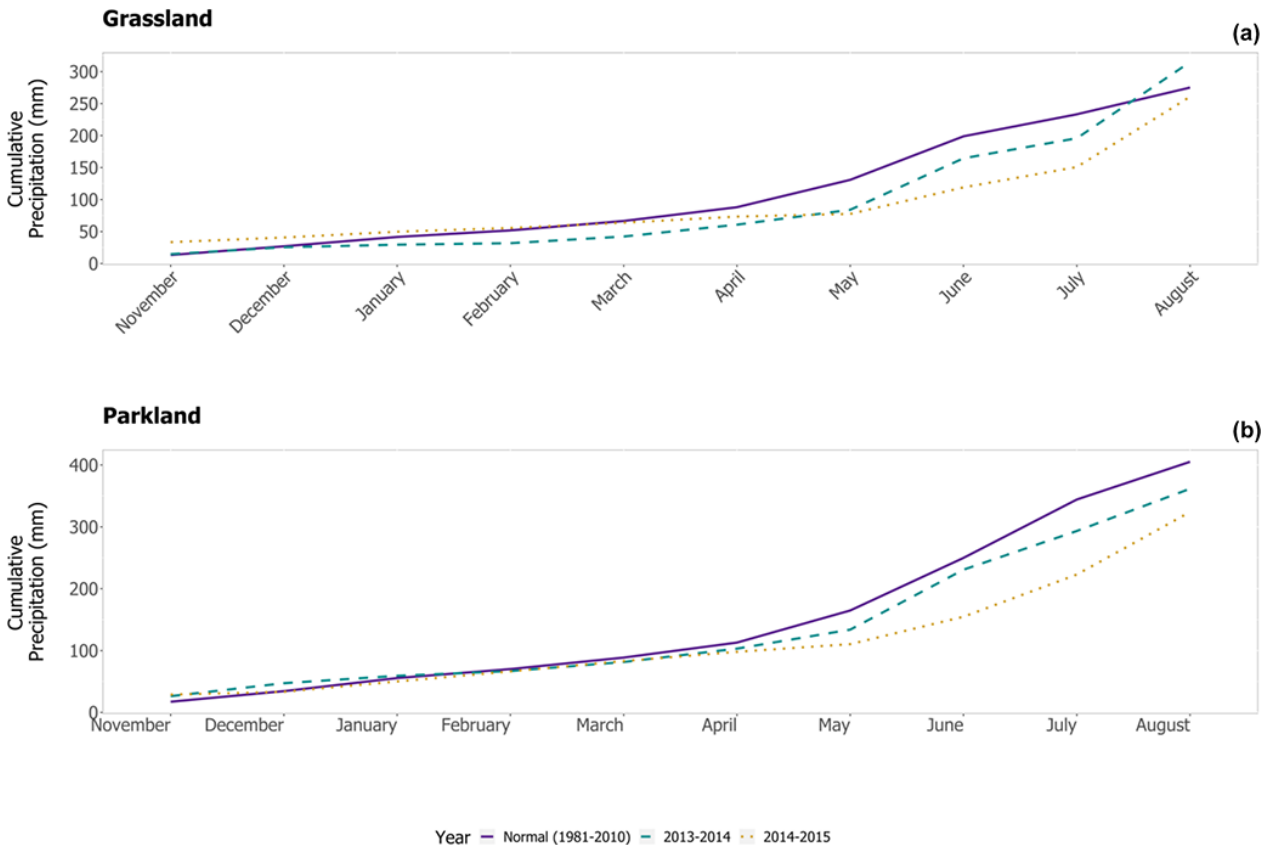
Figure B1. Comparison of cumulative precipitation in the (a) Grassland and (b) Parkland natural regions between 2013–2015 to the climate normal. Note that data were not available for the southern portion of the Boreal Forest Natural Region of interest in our study.